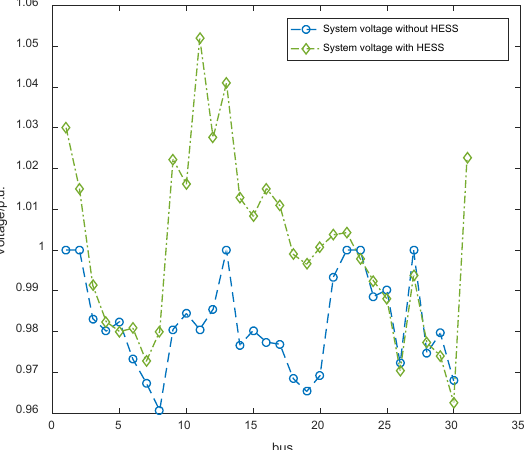
Figure 10. Optimized voltage comparison curve after distribution network.